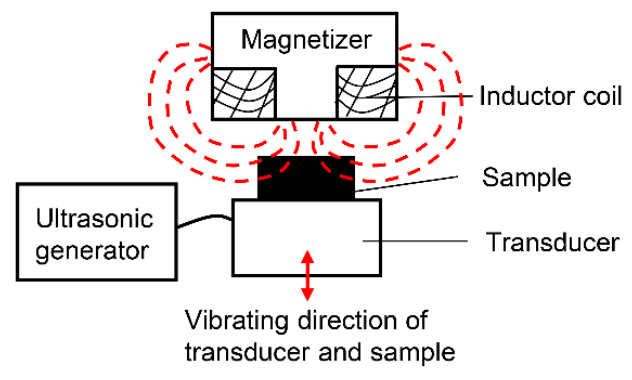
Figure 1. Schematic diagram of the experimental set.